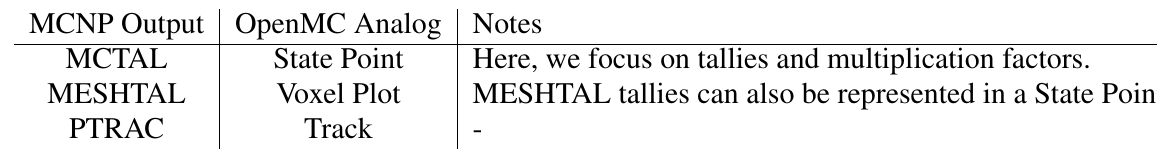
Table 1: MCNP output files and their OpenMC